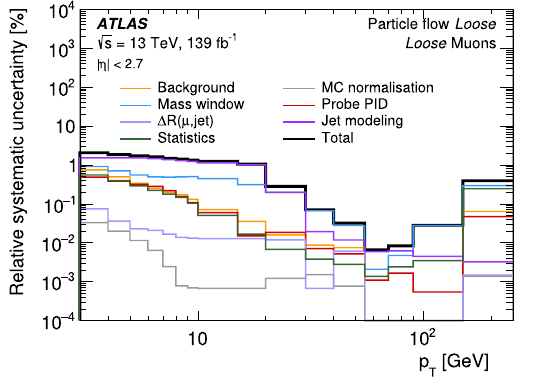
(cid:14) ( X | ST ) × (cid:14) ( ST | ID ) × (cid:14) ( ID | MS ) (cid:14) ( ST | X ) > 5GeV ) × (cid:14) ( ID | MS T